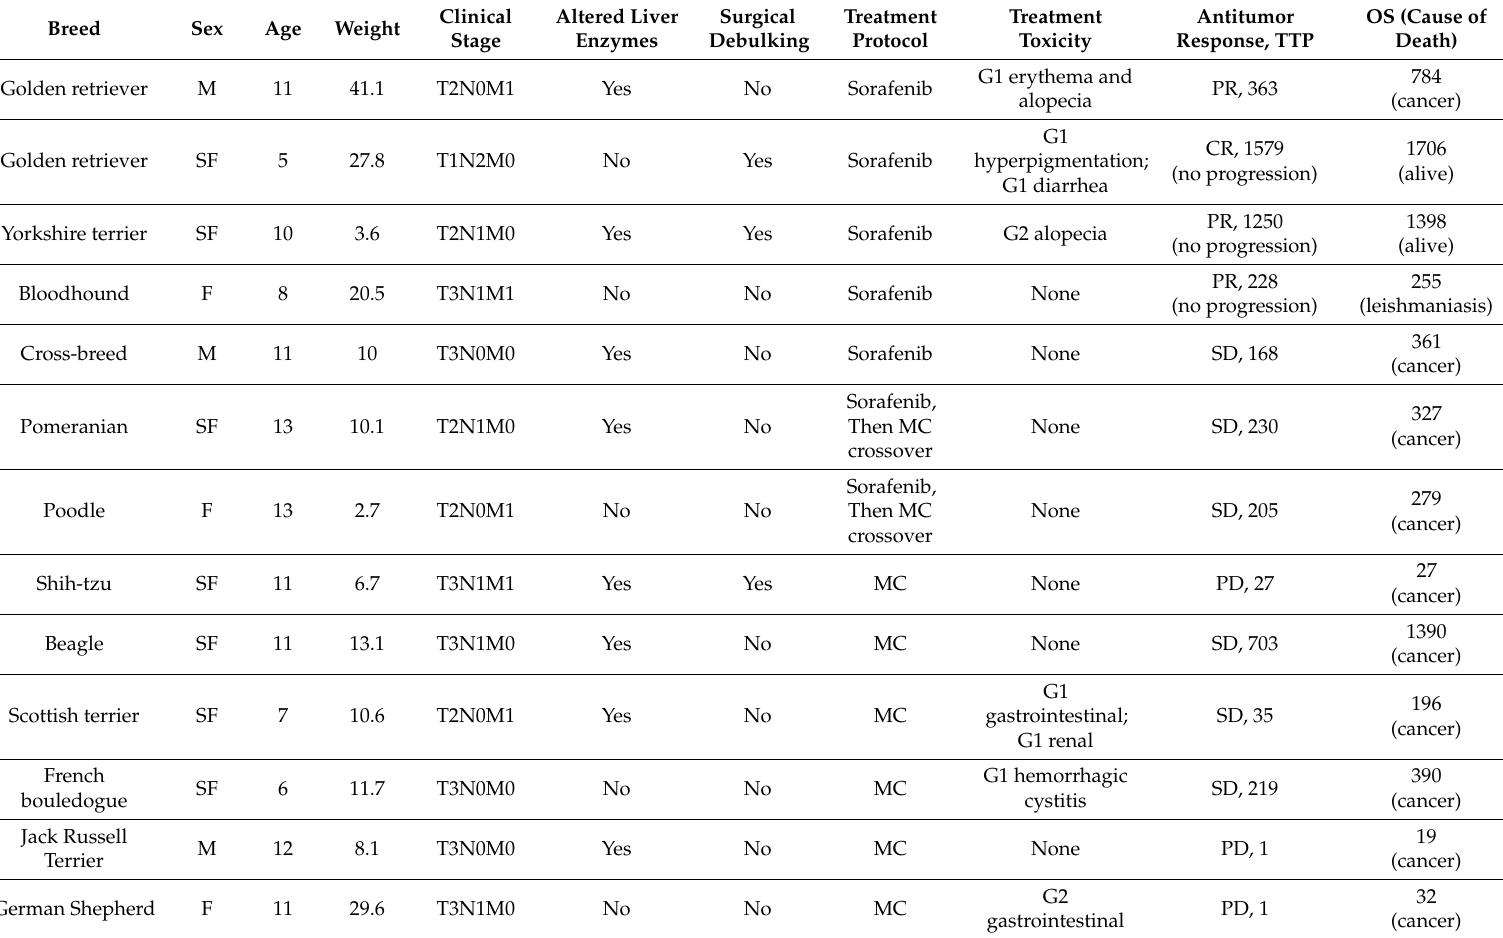
Table 1. Demographic and clinical details of 13 dogs with hepatocellular